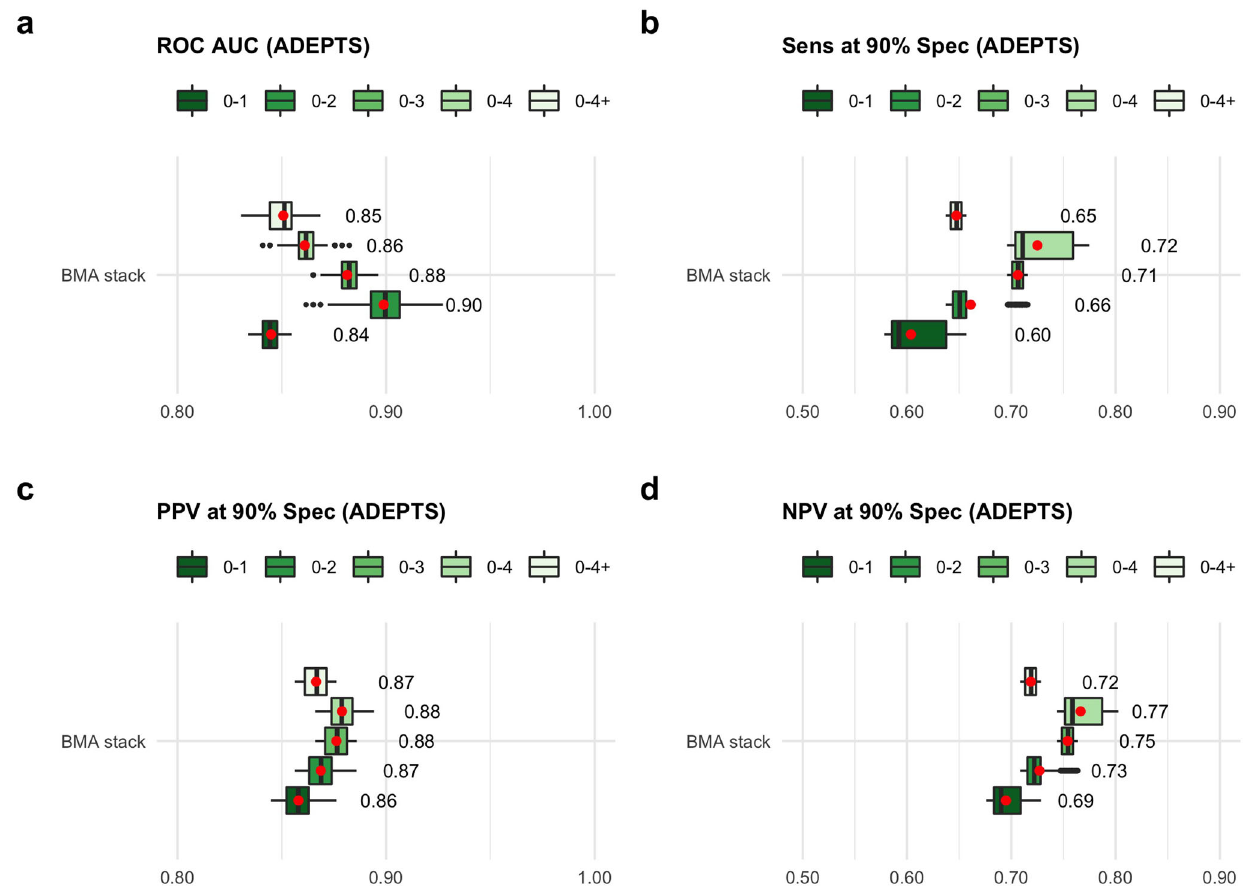
Fig. 4 Performance in an external validation set. a Receiver operating curve (ROC) area under the curve (AUC) in the Accelerated Diagnosis of neuro Endocrine and Pancreatic TumourS (ADEPTS) external validation set for the Joined Time Group 2 Layer (JTG2L) Bayesian Model Averaging (BMA) stack models developed and selected in the UKCTOCS training set in the respective joined time-group samples (see Fig. 1), coloured in shades of green from dark to light for 0-1, 0-2, 0-3, 0-4, 0-4 + YTD samples. b Sensitivity (Sens), c Positive predictive value (PPV) and d Negative predictive value (NPV) at 90% speci fi city (Spec) (see also Supplementary Fig. 39 for the corresponding Matthew ’ s correlation coef fi cient value). The performances correspond to 1000 datasets whose difference from the original ADEPTS subset selected for this study is the random allocation of the missing features hormone replacement therapy (HRT) and oral contraceptive pill use (OCP) to female participants. The red dots and respective numbers correspond to estimates of the mean performance in ADEPTS (by bootstrapping with the boot R package (version 1.3 – 25)) for the respective model developed in UKCTOCS time-grouped samples. The number of independent ADEPTS samples was n = 34. See ‘ Study design ’ and ‘ Statistical analysis ’ sections in Methods for further details, and Supplementary Data